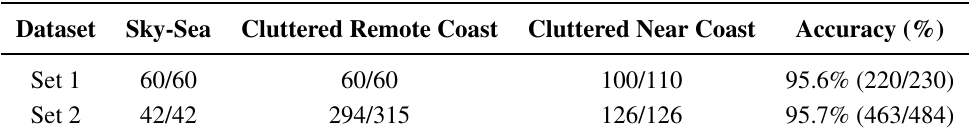
Figure 20. Composition of the infrared database. Infrared scene type classification performance for the test database using the proposed horizon and clutter density-based method.